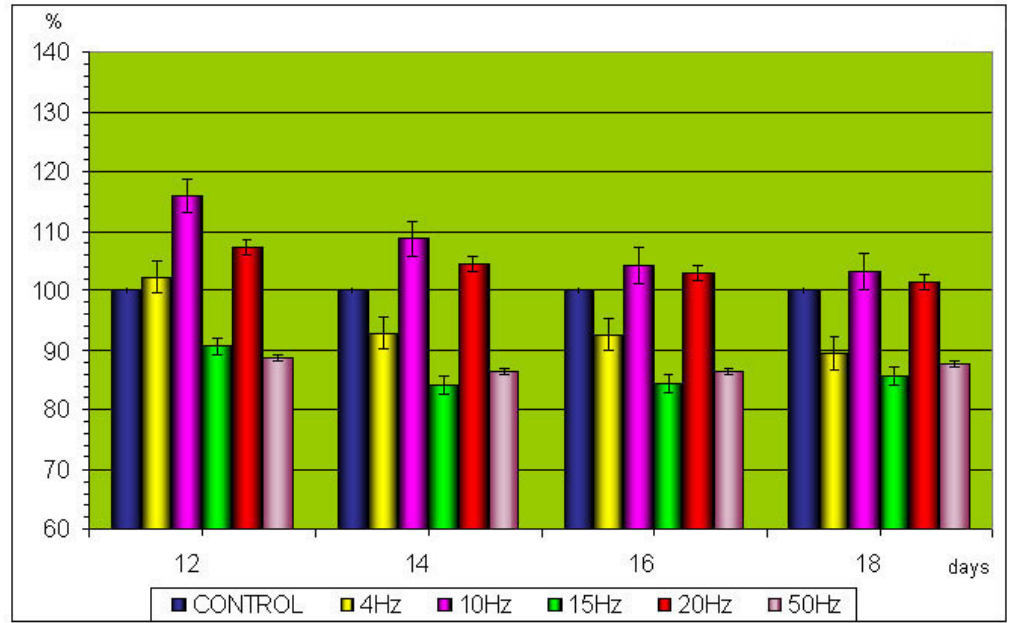
FIGURE 10. The time-dependent process of germination during 18-days incubation in nontreated (control) and ELFV- pretreated DW. On abscissa, the time (in days) of seed incubation; on ordinates, percent of the changes of germ length compared to the